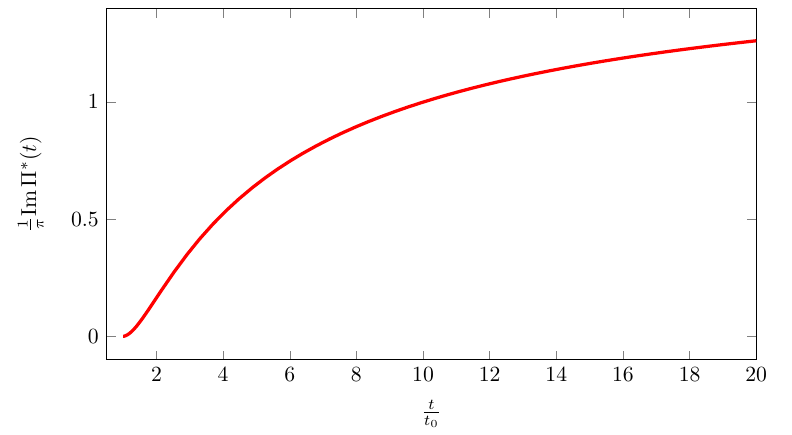
Figure 3 . Plot in α